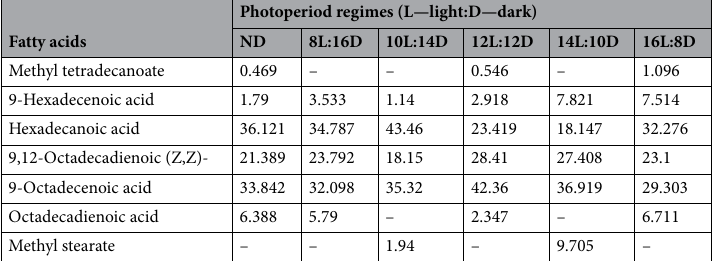
Table 1. Percent of fatty acids in non-diapausing (ND) and diapausing P. interpunctella larvae that had been exposed to different photoperiod regimes at 17 °C. – Not available.